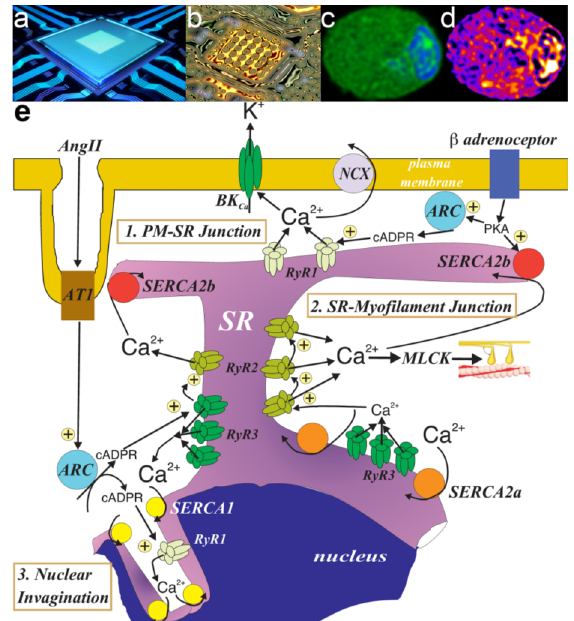
Figure 16. Calcium signalling is analogous to quantum tunneling across a cell-wide circuit with the nucleus at its centre. ( a ) and ( b ), Microprocessor at the centre of a circuit board. ( c ) (Fluo-4, green) and ( d ) (Fluo-4, pseudocolour), show the nucleus (Draq5 in (c) only, blue) at the centre of a cell-wide circuit of cytoplasmic nanocourses. e, Schematic shows calcium flux across cytoplasmic nanocourses demarcated by junctions between the plasma membrane and sarcoplasmic reticulum (PM-SR nanojunction), the sarcoplasmic reticulum nanojunctions aligned with the contractile myofilaments of a smooth muscle and the nuclear invaginations. Angiotensin II, AngII; Ryanodine receptor, RyR; Sarco/endoplasmic reticulum calcium ATPase, SERCA; sodium/calcium exchanger, NCX; ADP- ribosyl cyclase, ARC; Myosin light chain kinase, MLCK; AT1, Angiotensin AT1 receptor; Protein kinase A PKA; large conductance calcium-activated potassium channel, BK Ca . Panels (a) and (b) are free images. The schematic in panel ( e ) was adapted from previous versions developed and published by AME. Reprinted from Publication title, Vol /edition number, Author(s), Title of article / title of chapter, Pages No., Advances in Pharmacology , 78, Evans AM, Nanojunctions of the Sarcoplasmic Reticulum Deliver Site- and Function-Specific Calcium Signaling in Vascular Smooth Muscles, 1–47 Copyright (2017), with permission from Elsevier.